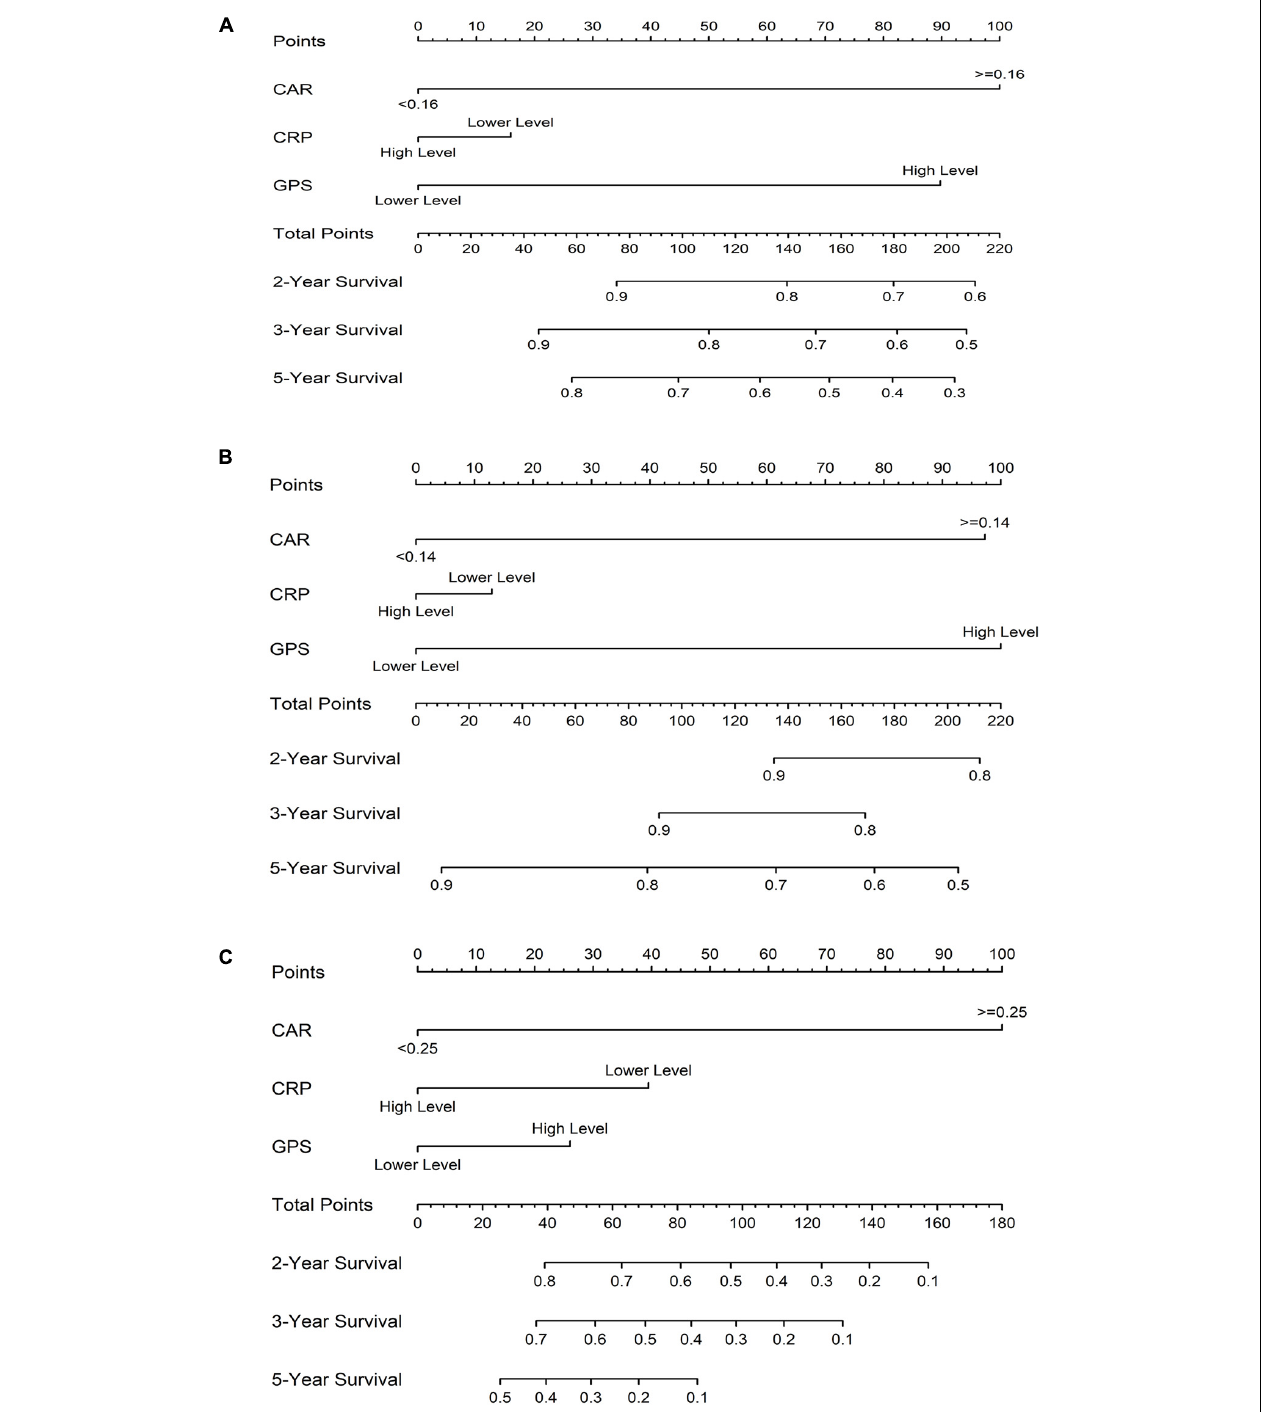
FIGURE 6 | Prognostic nomograms for overall survival (OS) based on the prognostic scores of inflammation in colorectal cancer (CRC) patients (A) , in the stage I–III CRC cohort (B) , and in the colorectal liver metastases (CRLM) cohort (C) .